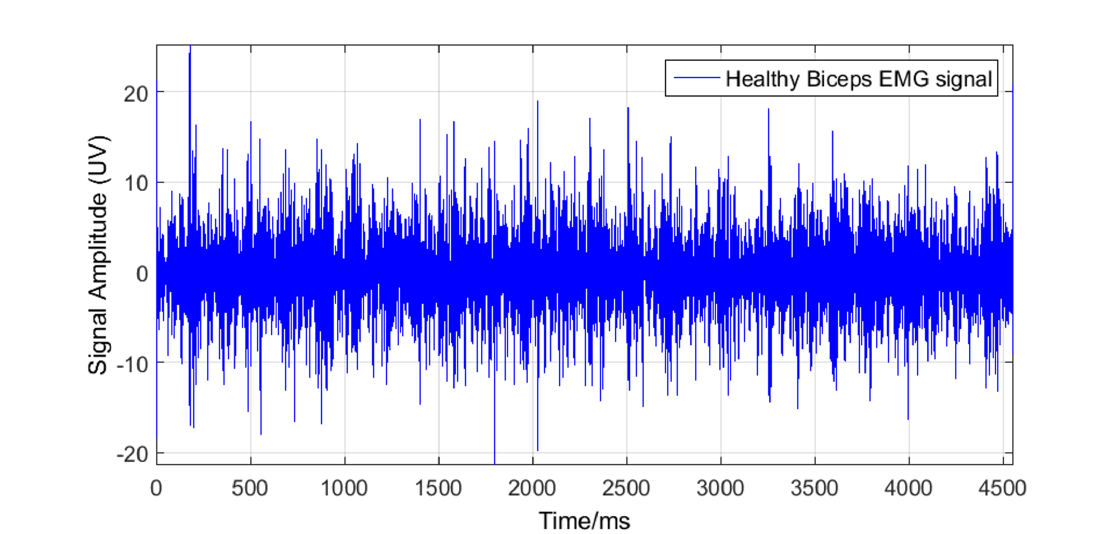
Figure 7. EMG (Biceps) signal of a healthy